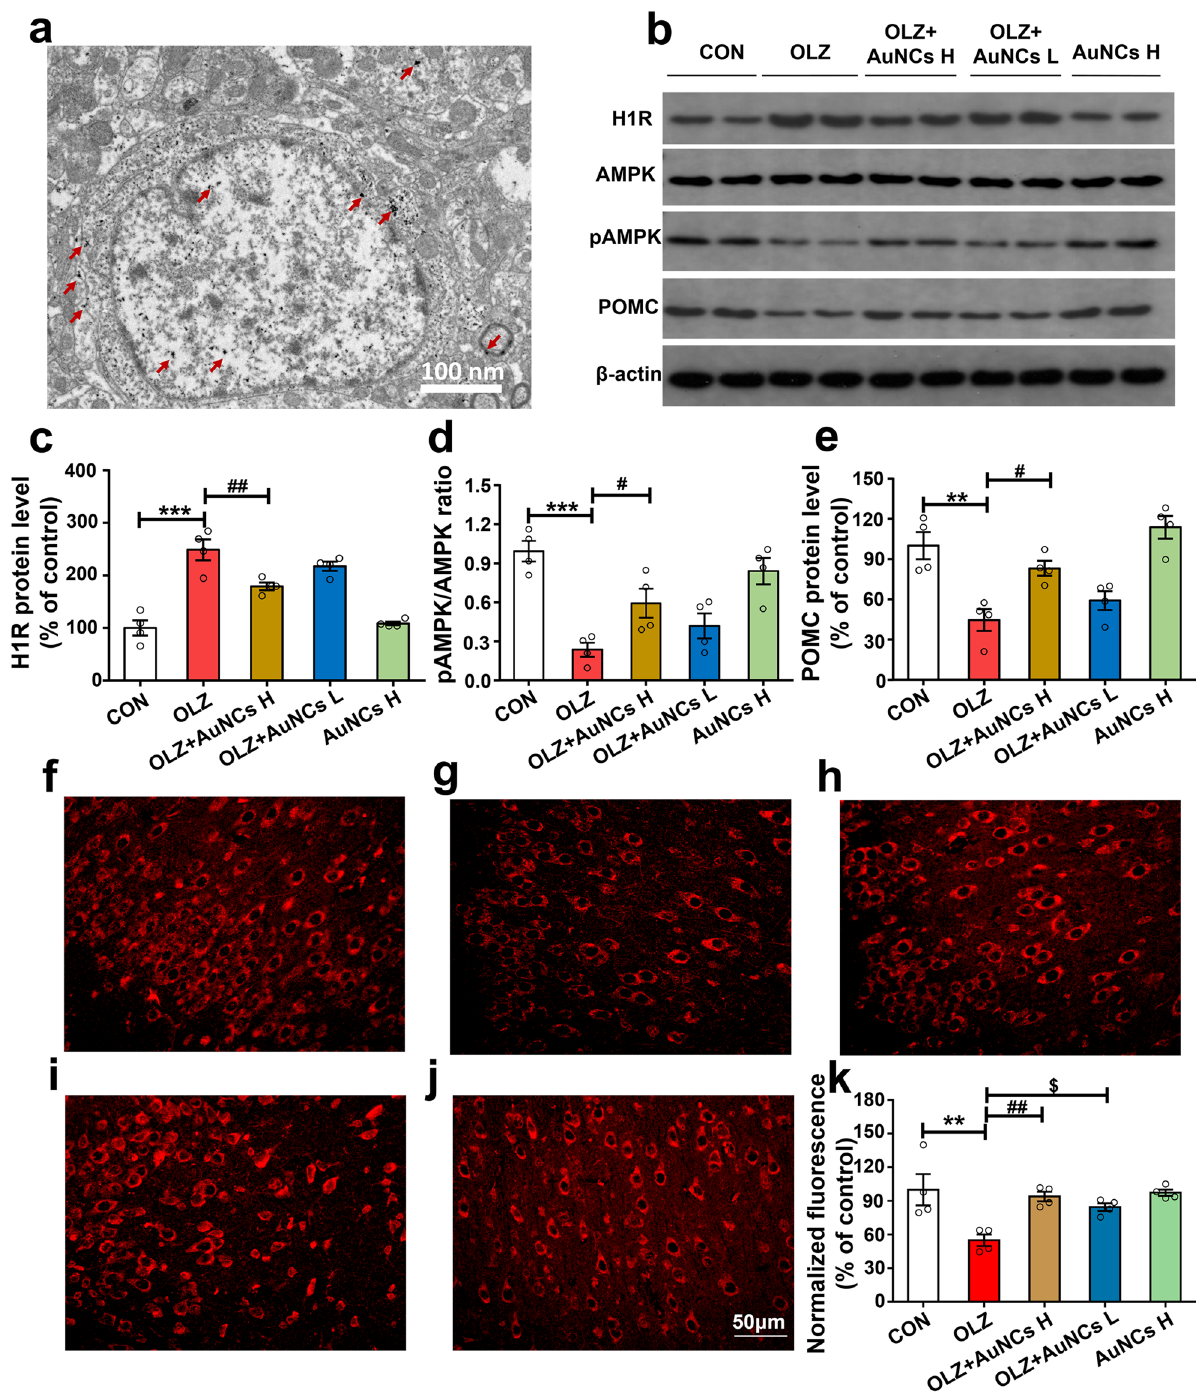
Figure 3. Effects of olanzapine and AuNCs co-treatment on H1R-AMPK signaling, POMC protein expression and POMC immunofluorescence staining in the hypothalamus. ( a ) TEM image of a hypothalamic slice